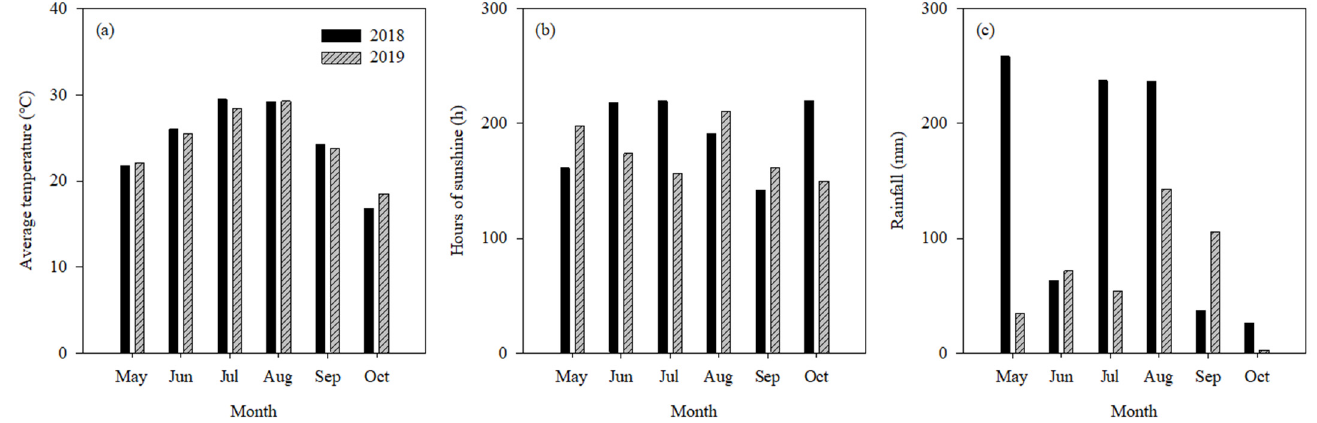
Figure 1. Average temperature ( a ), hours of sunshine ( b ), and rainfall ( c ) per month during rice growing periods in 2018 and 2019.